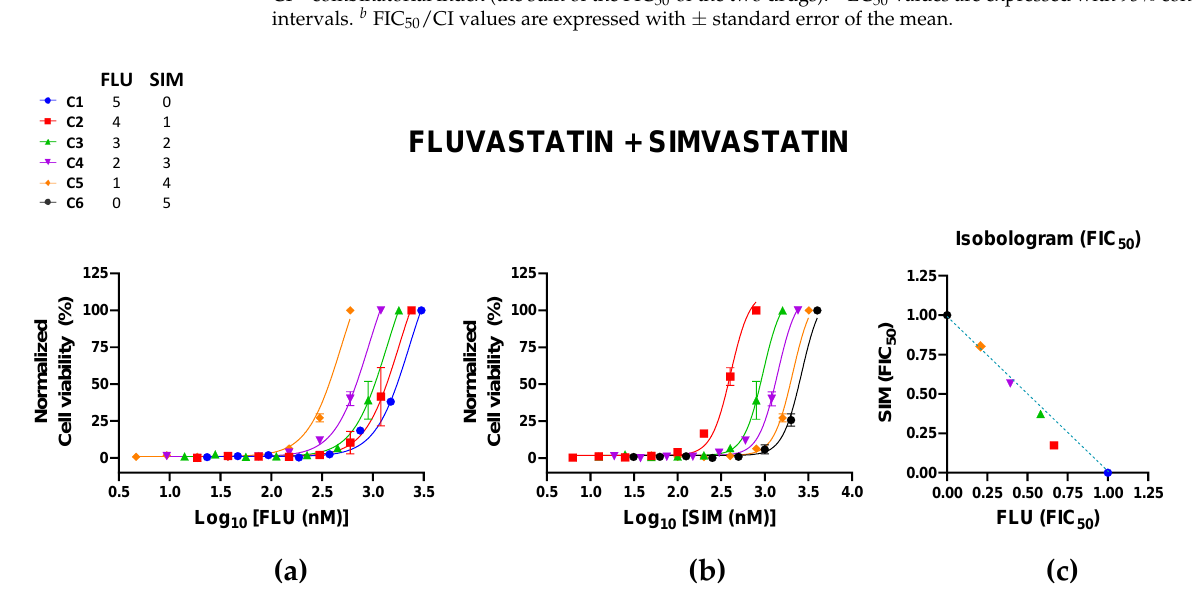
Figure 4. Effects of the combination of fluvastatin (FLU) and mevastatin (SIM) on Zika virus (ZIKV) infection. Vero cells were infected with ZIKV (MOI of 0.02) and treated with different combinations of FLU and SIM. Normalized cell viability of ZIKV-infected cells in response to the different concentrations of ( a ) FLU and ( b ) SIM in these different combinations are shown. All datapoints represent the mean ± SEM of 2 independent experiments per combination. ( c ) The normalized isobologram was constructed based on the mean FIC 50 of each statin (Table 4). Colors and symbols in the legend correspond to those in ( a – c ).